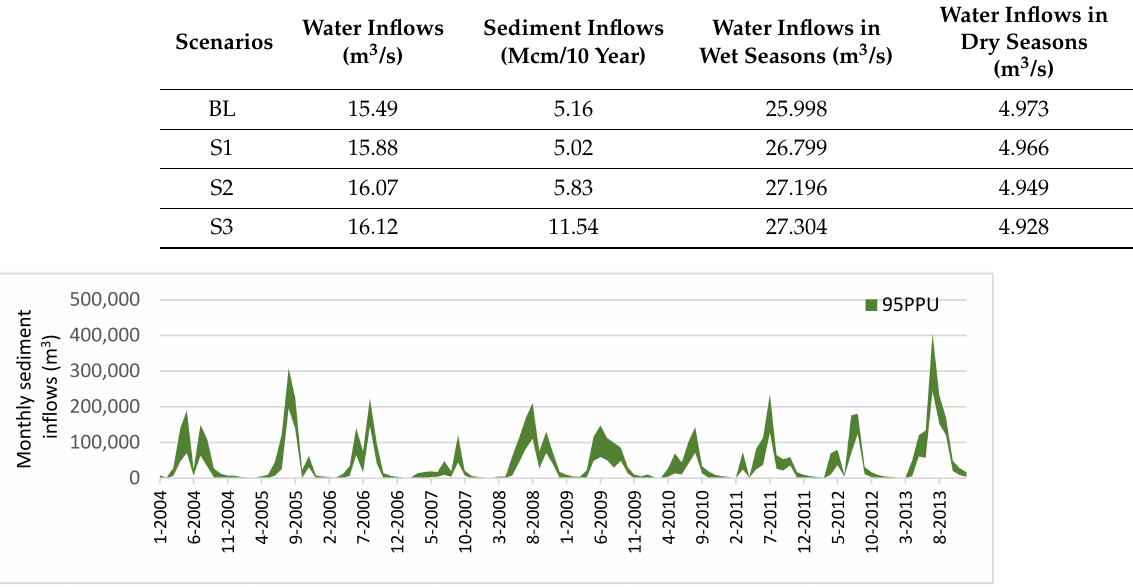
Figure 8. Sediment inflows into the reservoir using the baseline land-use